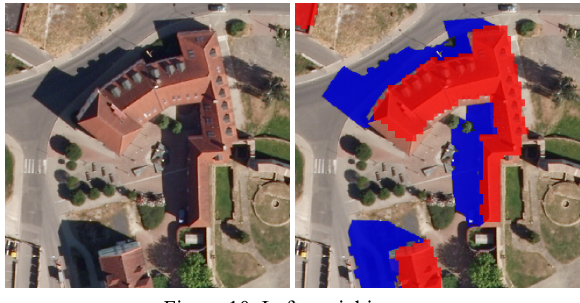
Figure 10. Left: aerial image Right: classified buildings (red) and their shadows (blue)